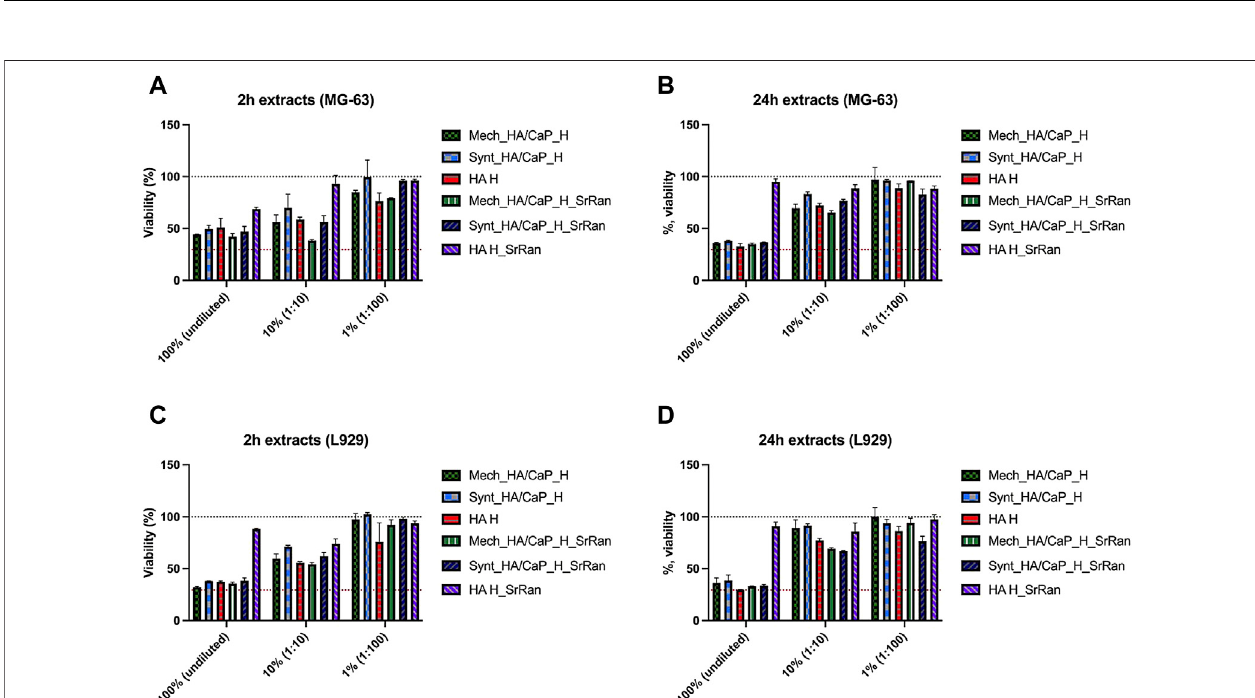
FIGURE 11 | Cytotoxicity assessment of undiluted and diluted hydrogel extracts in MG-63 human osteoblast (A,B) and L929 mouse fi broblast (C,D) cell cultures. (A) 2 h extracts for MG-63; (B) 24 h extracts for MG-63; (C) 2 h extracts for L929; (D) 24 h extracts for L929. The black dotted line corresponds to the control (100%, cells cultivated in standard cultivation media), and the red dotted line represents cytotoxicity control DMSO (viability 29.57 ± 6.54%), n = 6.